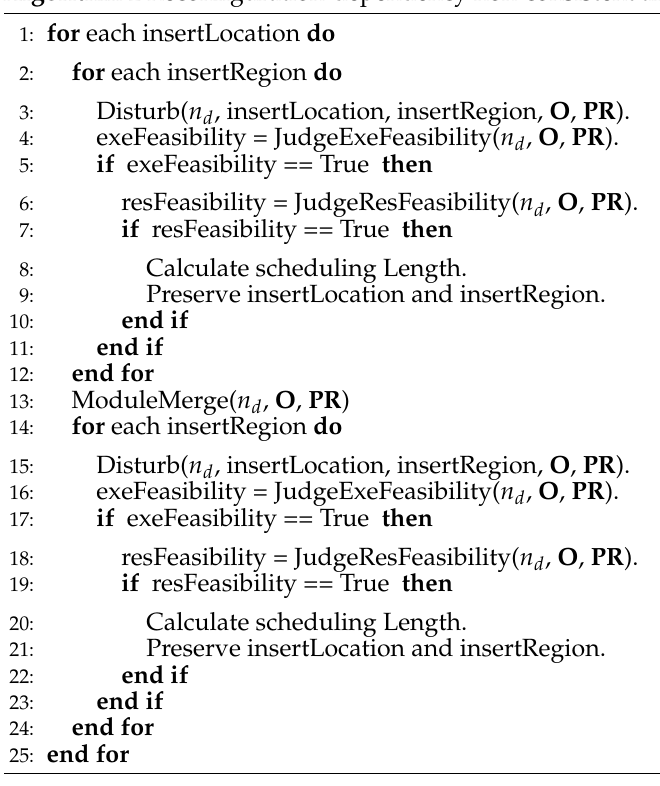
Algorithm 2 Reconfiguration-dependency non-consistent algorithm